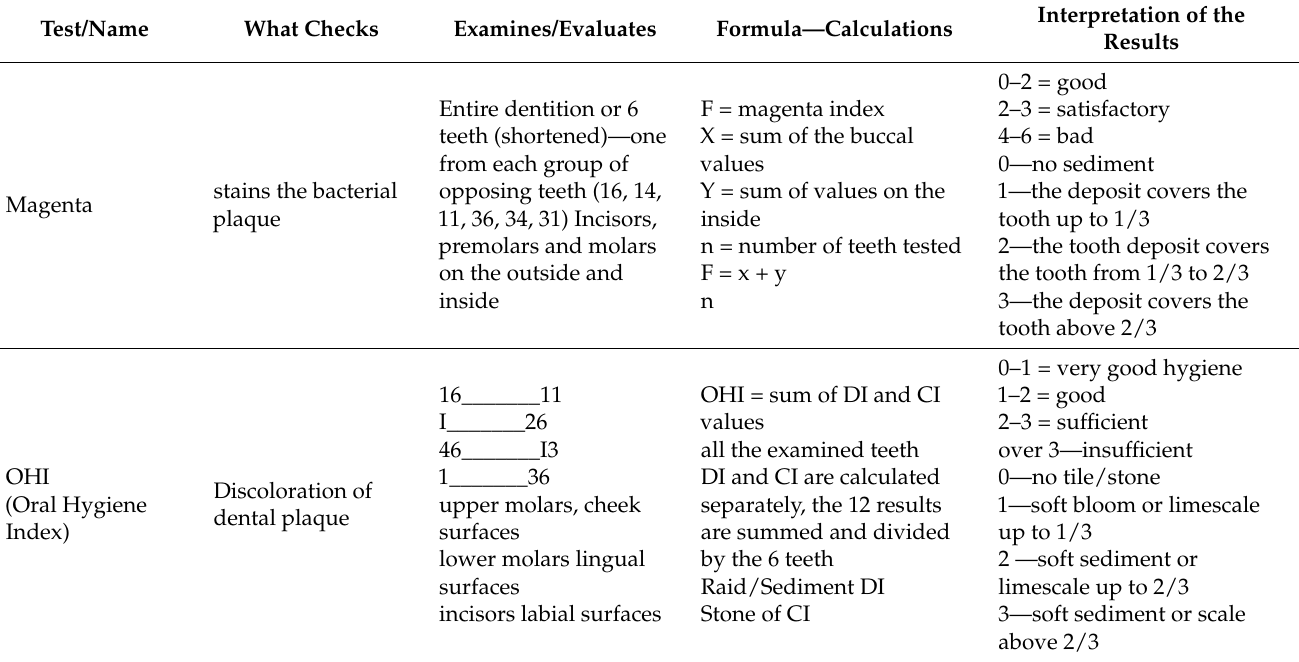
Table 1. The mainly indicators commonly used in